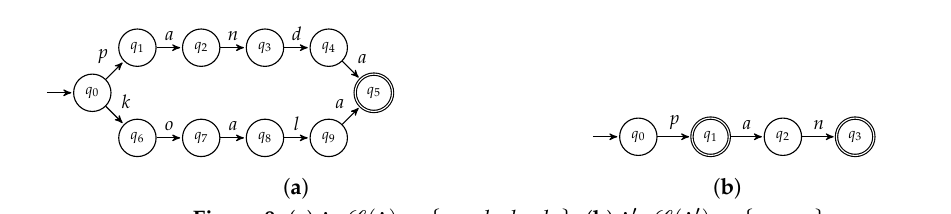
Figure 9. ( a ) A , L ( A ) = { panda , koala } . ( b ) A (cid:48) , L ( A (cid:48) ) = { pan , p }